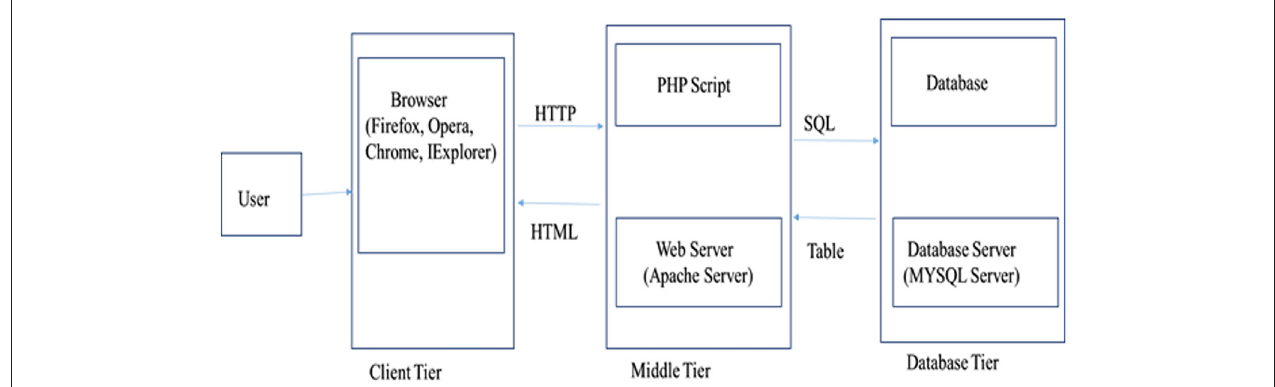
FIGURE 1 | Three tier architecture representing client, middle and database tier of WBMSTDb